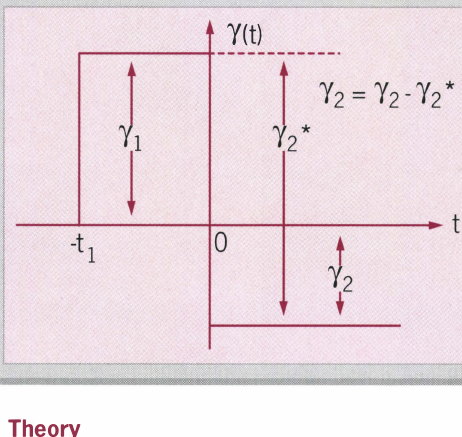
Fig. 2: Experimental results for strain sequences B, C, and D; t1 = 0.2s